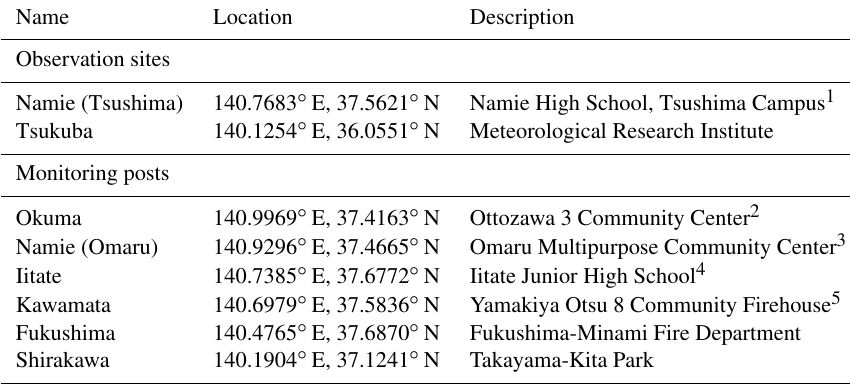
Table 1. The observation sites and monitoring posts used to provide data for this